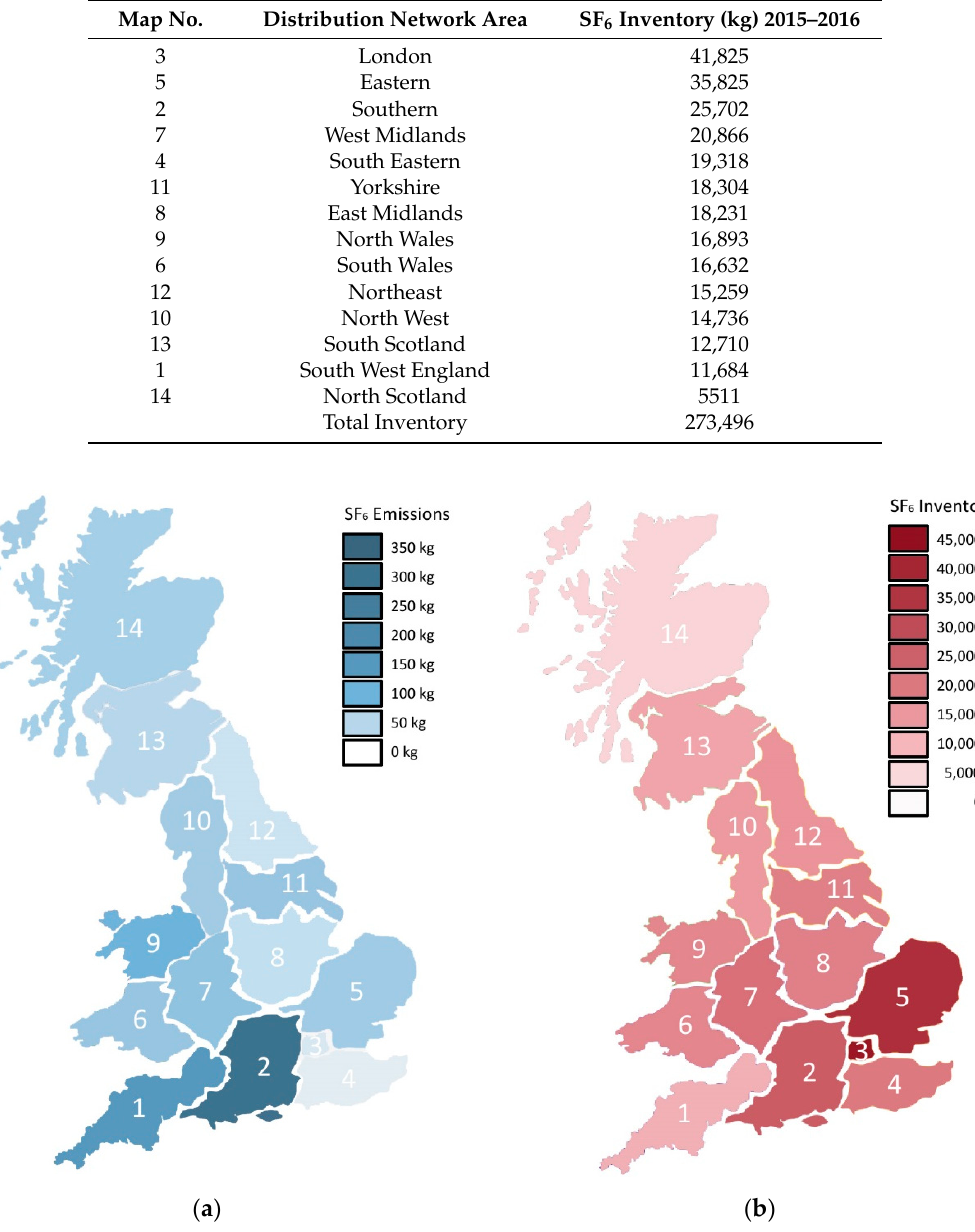
Table 6. SF 6 inventory of the distribution network (kg) in Great Britain (2015–2016) [13,16,17,19,21,24,32,40,44]. Map No.